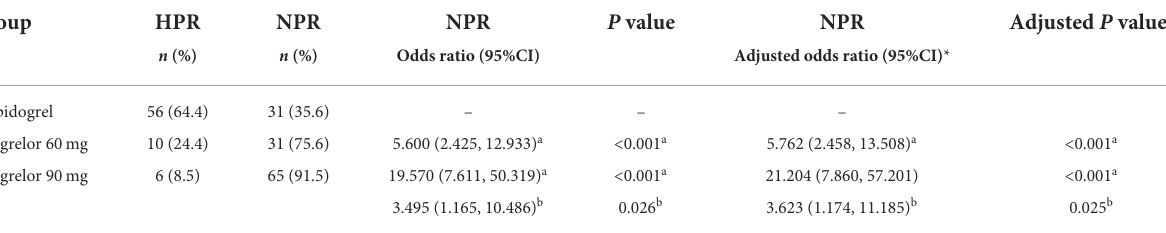
TABLE 2 Platelet reactivity in patients with ACS.